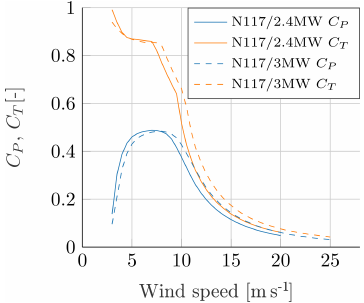
Figure 3. Power and thrust coefficients over wind speed for the N117 3MW and the N117 2.4MW turbines.